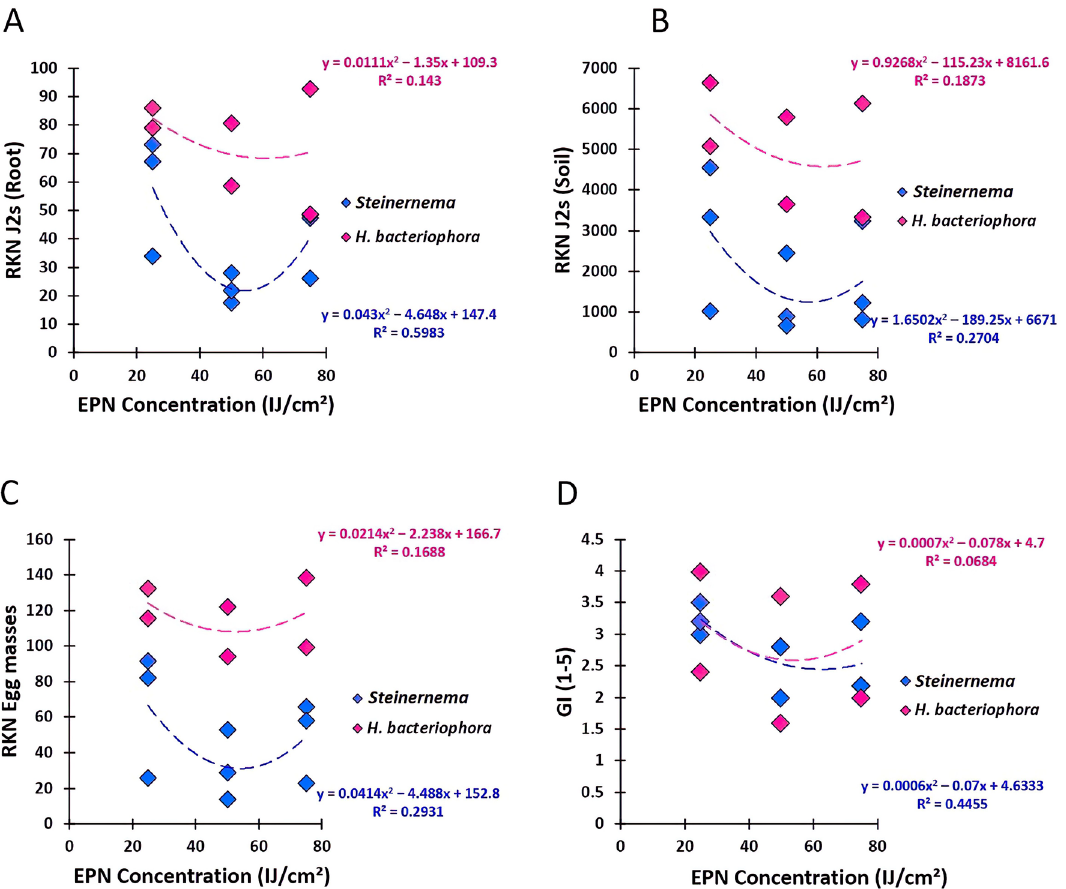
Figure 3. Polynomial regression analysis showed the relationship between M. javanica parameters and different concentrations of EPN ( Steinernema sp . , S. feltiae and H. bacteriophora ). ( A ) regression EPN-J2s per root system. ( B ) regression EPN-J2s in soil matrix. ( C ) regression EPN-Egg-masses. ( C ) regression EPN-Galling index. Values of R 2 for Steinernema strains were significant at P <